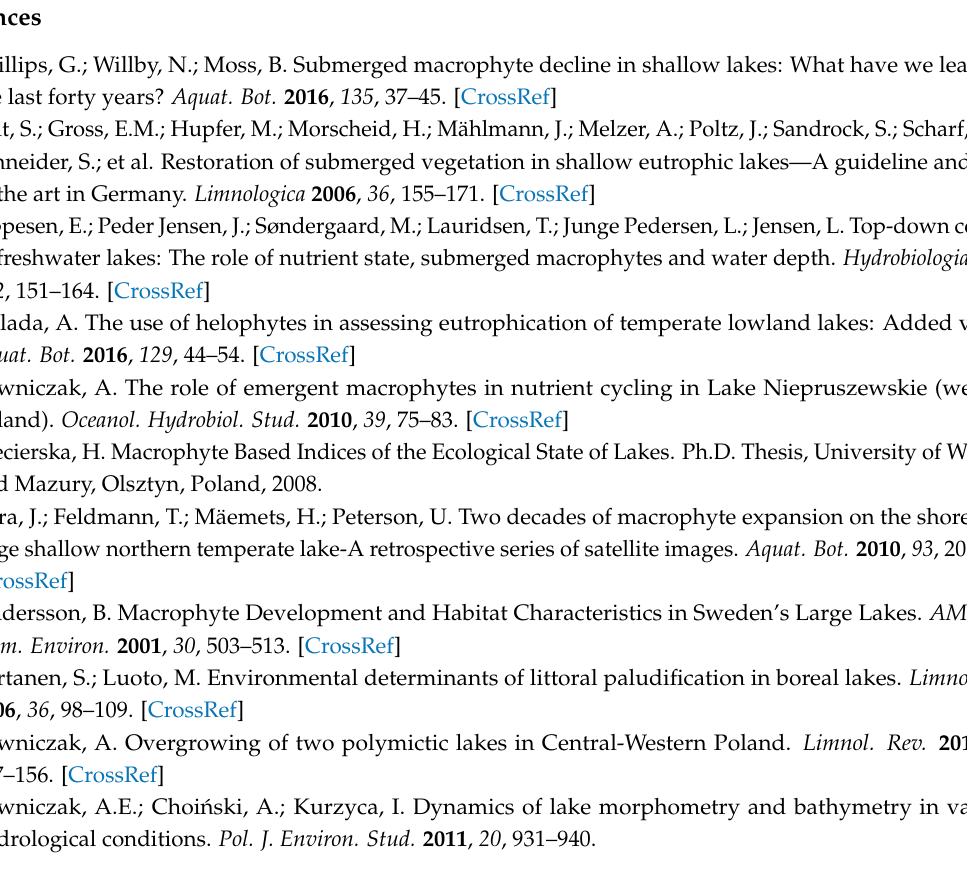
Table S1: Selected morphological parameters and localization of the lakes